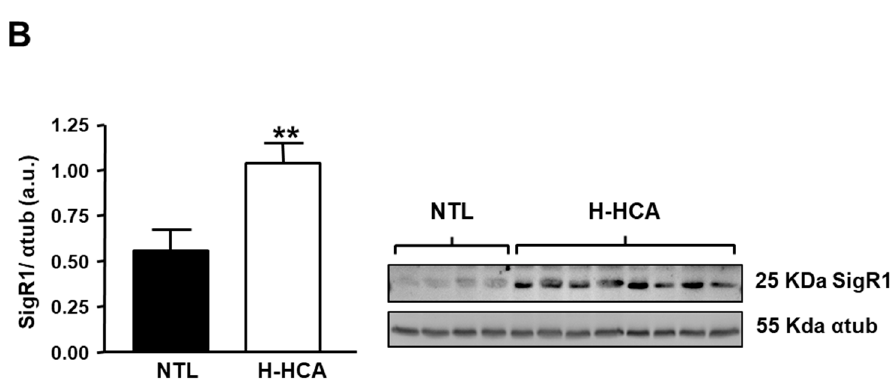
Figure 4. Expression of SigR1 in HCA subtypes. ( A ) Relative mRNA expression of SigR1 in H-HCA subtype ( n = 119) compared to non-tumoral liver (NTL, n = 25) and other HCA ( n = 260) (see Table S1). p = 7.20 × 10 − 9 (Wilcoxon rank sum test). ( B ) Protein expression of SigR1 by Western Blot and quantification in non-tumoral liver (NTL, n = 7) compared to H-HCA ( n = 12). p = 0.0069. Mann–Whitney U test. ** p < 0.01; **** p < 0.0001. More details of western blots, please view at the supplementary materials.